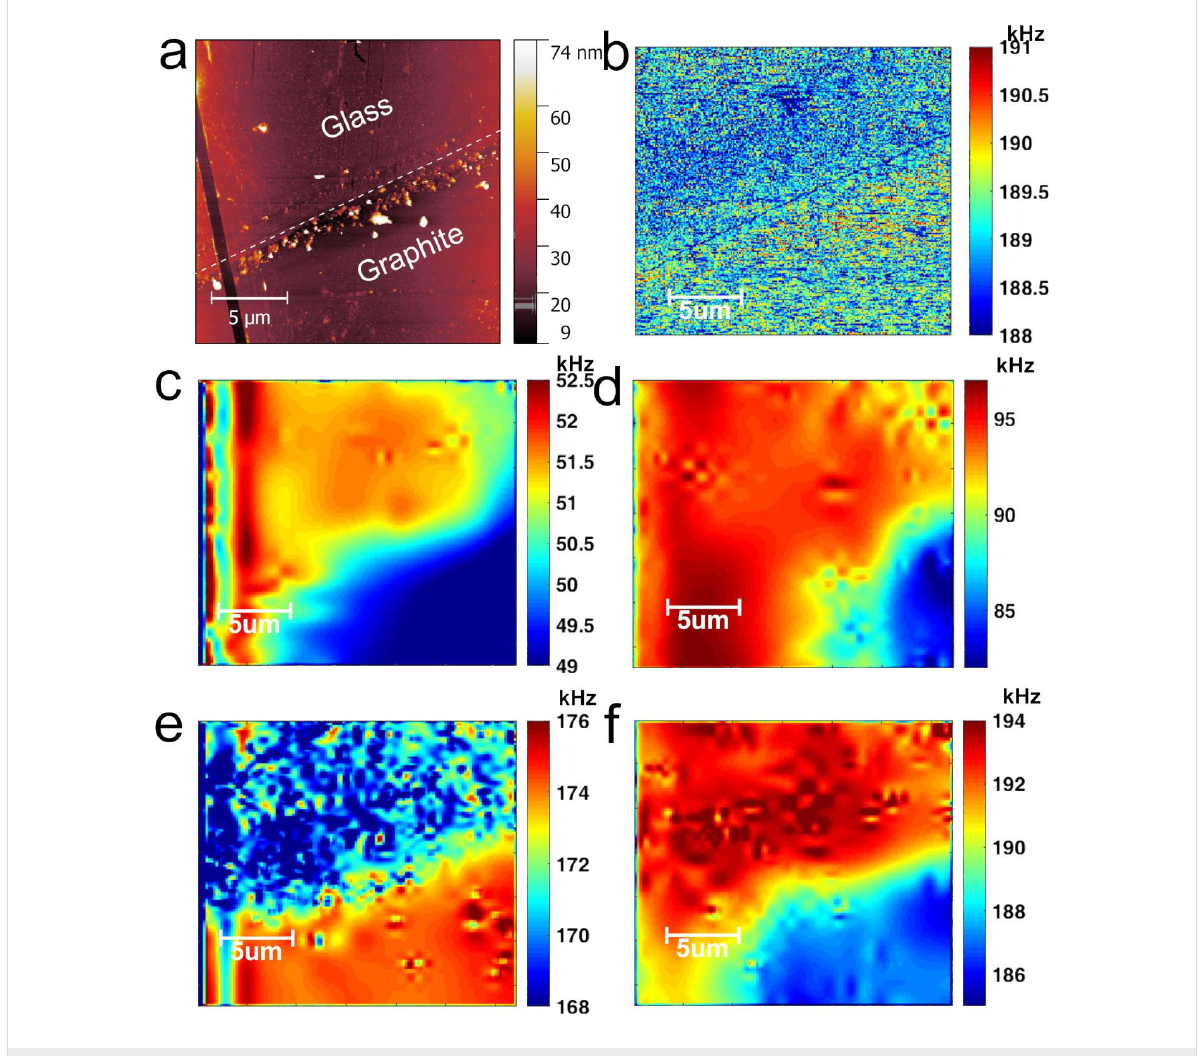
Figure 6: Results for a graphite film on a glass substrate. a) Conventional AFM topography; b) RT-AFAM for 188–191 kHz window; and S-AFAM fre- quency maps for c) 49–53 kHz window, d) 82–97 kHz window, e) 168–176 kHz window and f) 186–194 kHz